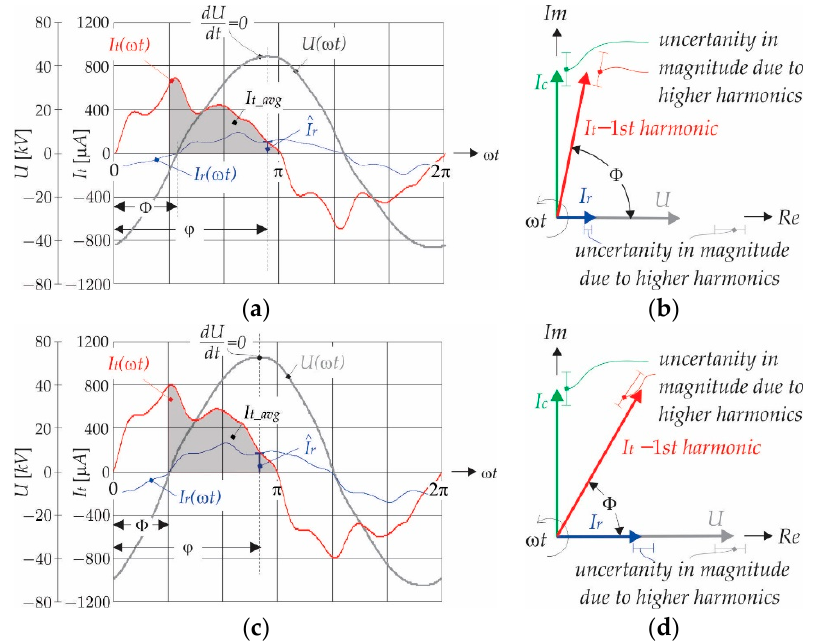
Figure 1. ( a ) Current and voltage wave shape when U = 27 [kV] rms ; ( b ) Phasor diagram, when Φ = 72°; ( c ) Current and voltage wave shape when U = 37 [kV] rms ; and, ( d ) Phasor diagram, when Φ = 64°.